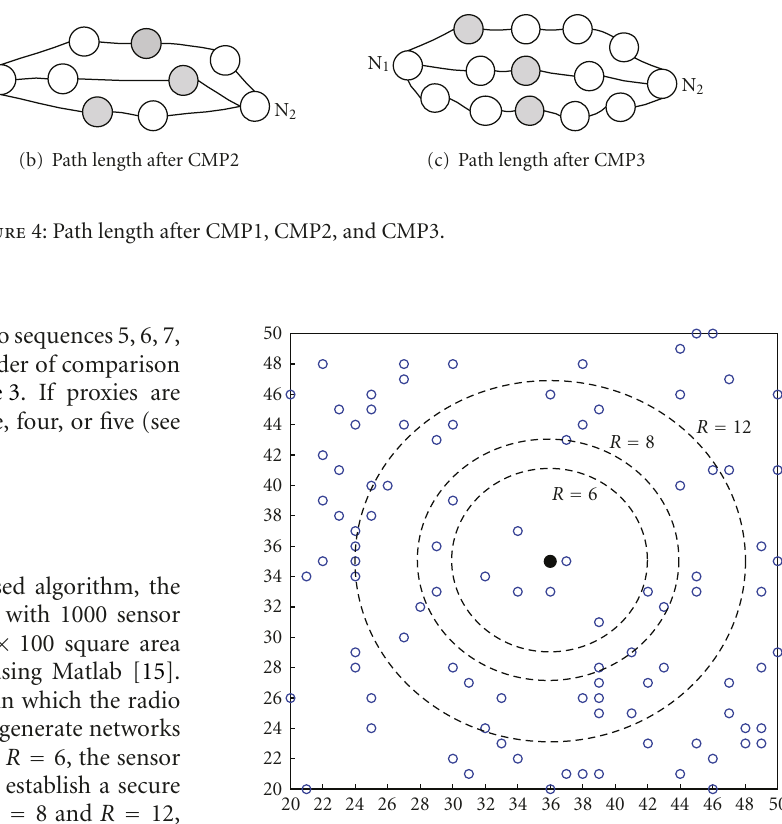
Figure 5: Varying radio range and